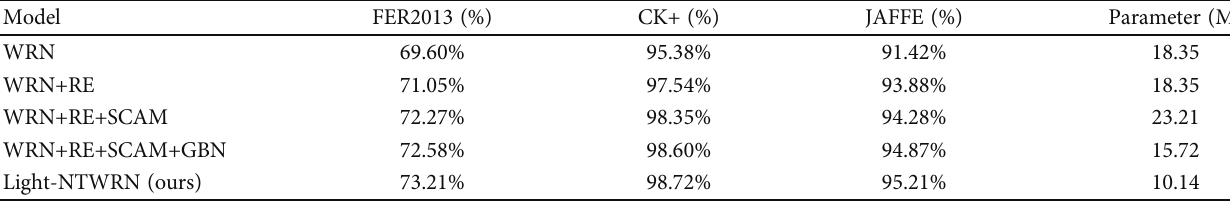
Table 5: Light-NTWRN network ablation